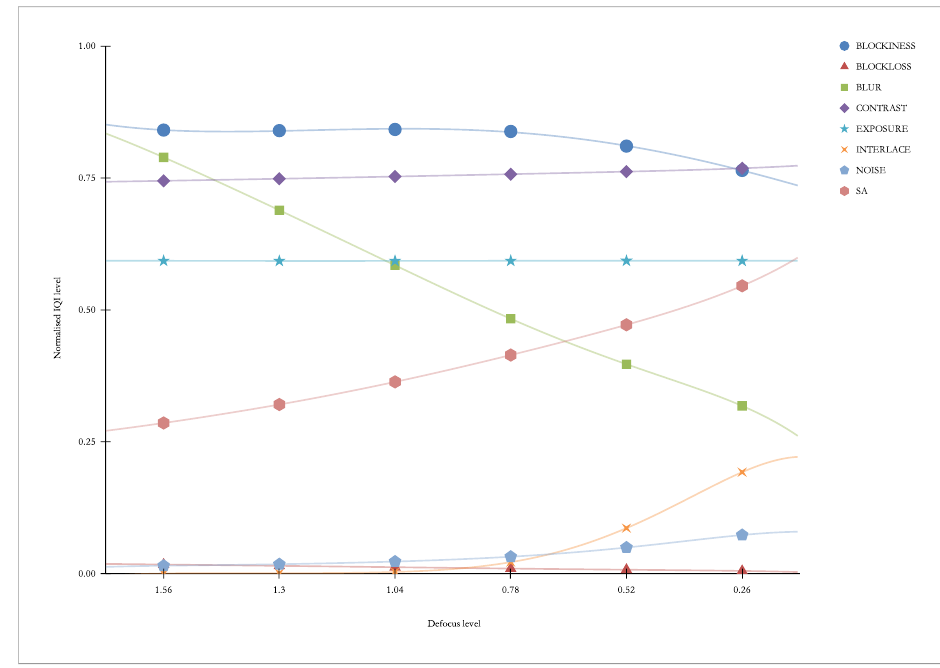
Figure 15. “Our” indicators vs. Defocus [ σ /pixels].